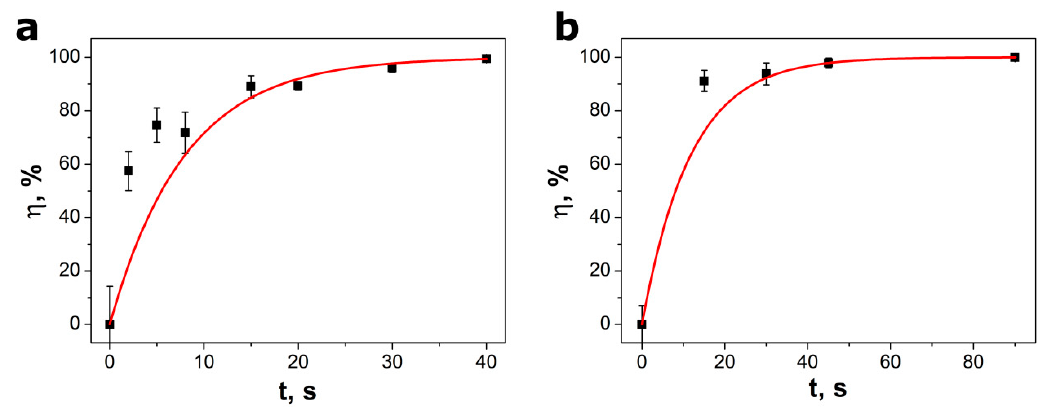
Figure 6. The ratio of piezocatalytic decomposition of methyl orange as a function of ultrasonic irradiation carried out with two different reactors: ( a ) VCX-750 (f = 20 kHz, P = 750 W) and ( b ) Sonic-6 (f = 40 kHz, P = 480 W). Red lines represent the best fitted dependence described by Equation (2).